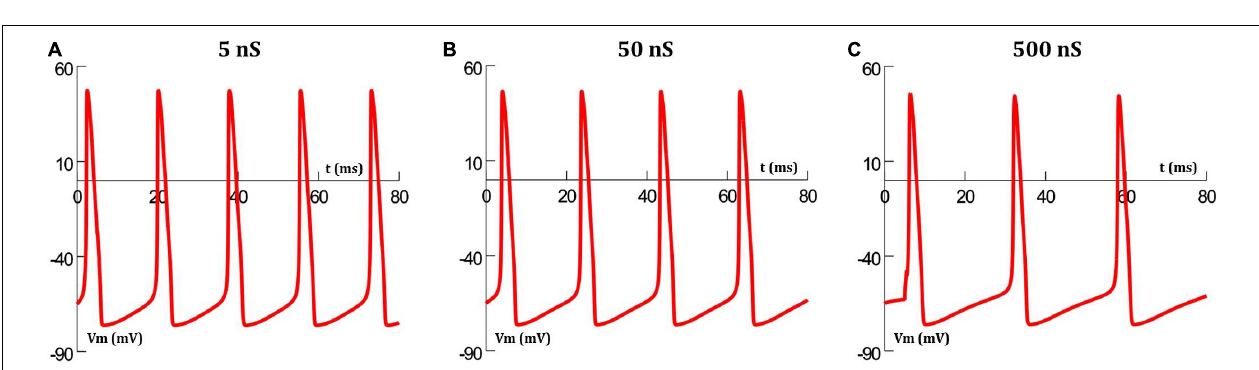
FIGURE 2 | Hodgkin-Huxley action potential profile in a single isolated cell (A) with standard parameter values produces a single AP when stimulated, but thereafter settles back to resting potential, (B) with increased maximum sodium conductance, the short initial stimulus triggers the first AP, and thereafter enters into oscillations without any further external stimuli.